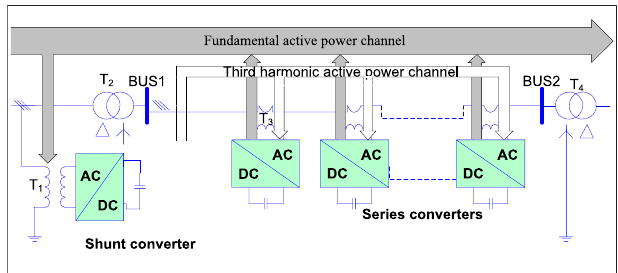
FIGURE 1 | Con fi guration and principle of the